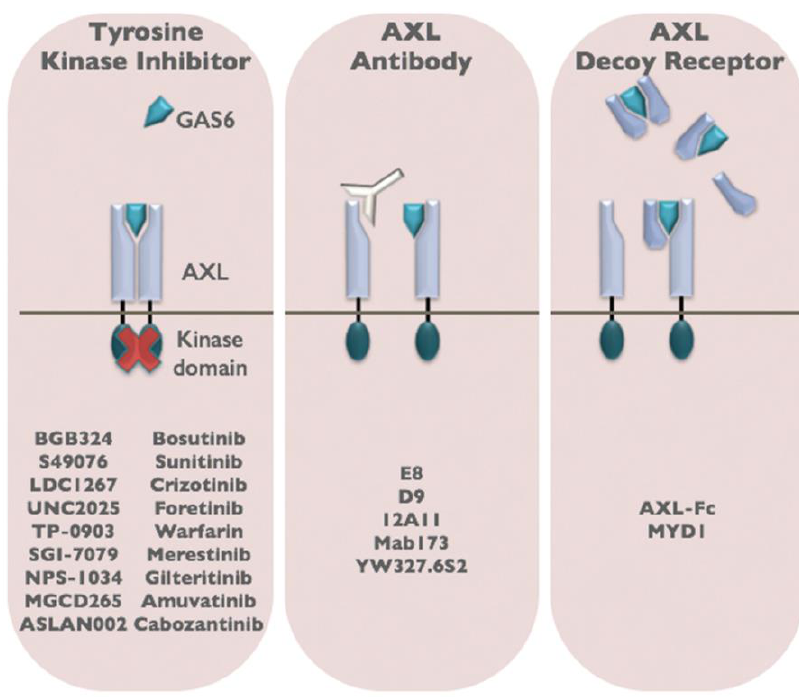
Figure 3. Three classes of AXL inhibitors have been developed for cancer therapy. Small molecule tyrosine kinase inhibitors that block AXL kinase activity, anti-AXL antibodies, and soluble AXL decoy receptors are in preclinical and clinical development for the treatment of cancer.